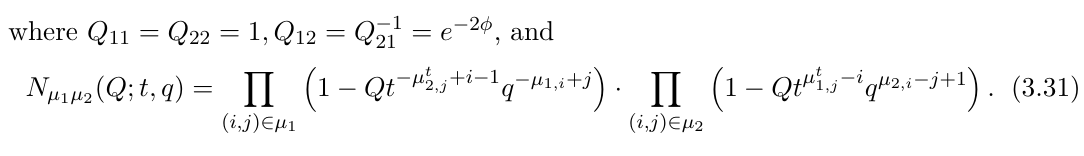
Figure 4 . Brane diagrams in the x 5 , 6 directions. (a) The brane diagram for SU(2) gauge theory with one flavor. C is the curve class related to the edge in the diagram. (b) The brane diagram with an infinitely long curve C